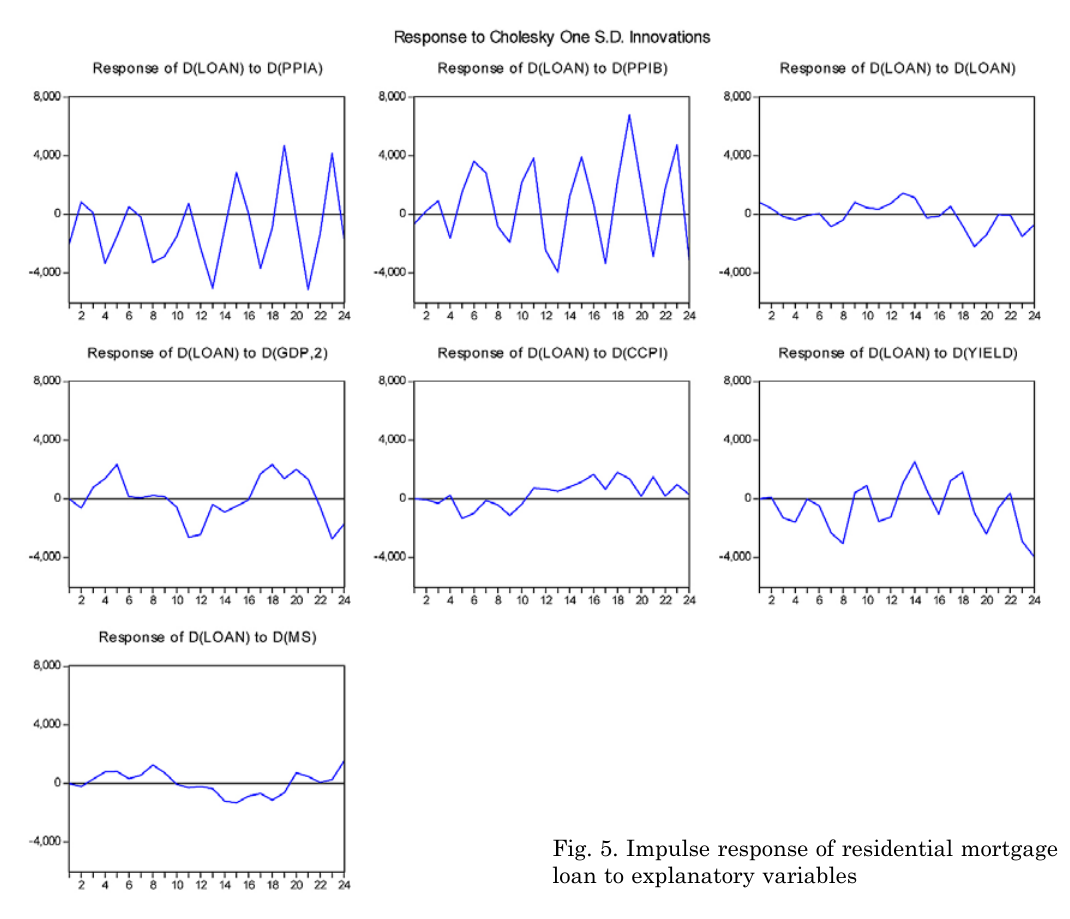
Fig. 5. Impulse response of residential mortgage loan to explanatory